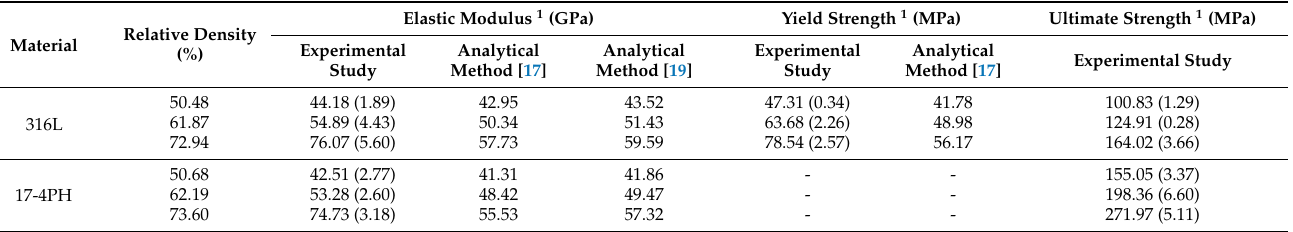
Table 4. The mechanical properties of the infill specimens obtained from the tensile tests and analytical